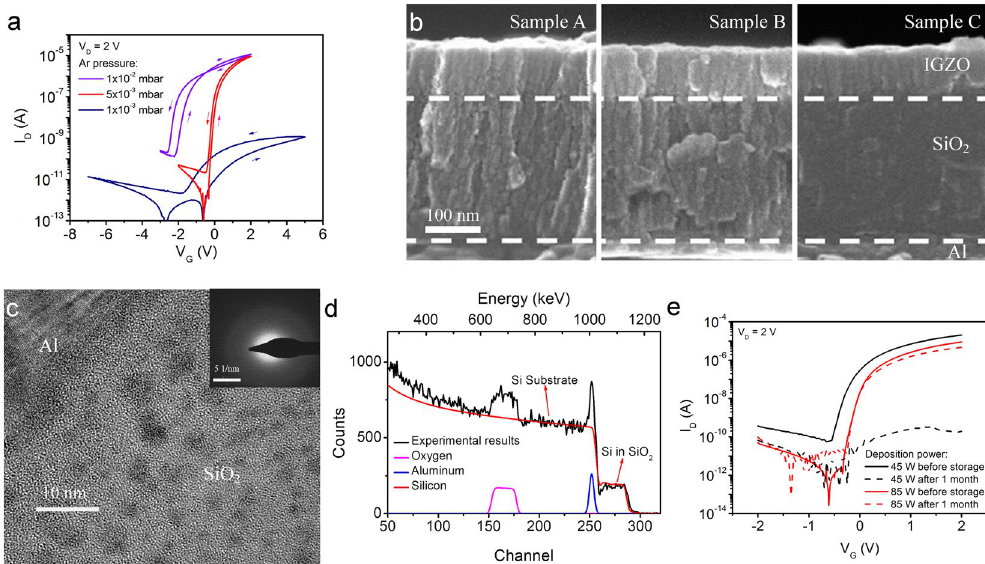
Figure 2. Effects of difference sputtering conditions. ( a ) Transfer characteristics of the IGZO TFTs based on the SiO 2 gate dielectric sputtered at 85 W with Ar pressures of 1 × 10 − 2 , 5 × 10 − 3 , and 1 × 10 − 3 mbar, respectively. ( b ) High resolution cross-section SEM images of the TFTs with the SiO 2 gate dielectric sputtered at Ar pressures of 1 × 10 − 2 (left, Sample A), 5 × 10 − 3 (middle, Sample B), and 1 × 10 − 3 mbar (right, Sample C), respectively. ( c ) Cross-sectional HRTEM bright field micrograph of the SiO 2 layer. The SAED image of the SiO 2 film is shown in the inset. ( d ) Rutherford backscattering spectrum of the SiO 2 electrolyte deposited on Al/Si substrate at 85 W with an Ar pressure of 5 × 10 − 3 mbar. ( e ) Transfer characteristics of the TFTs using 45 W-sputtered and 85 W-sputtered SiO 2 as gate dielectric after one month in atmospheric